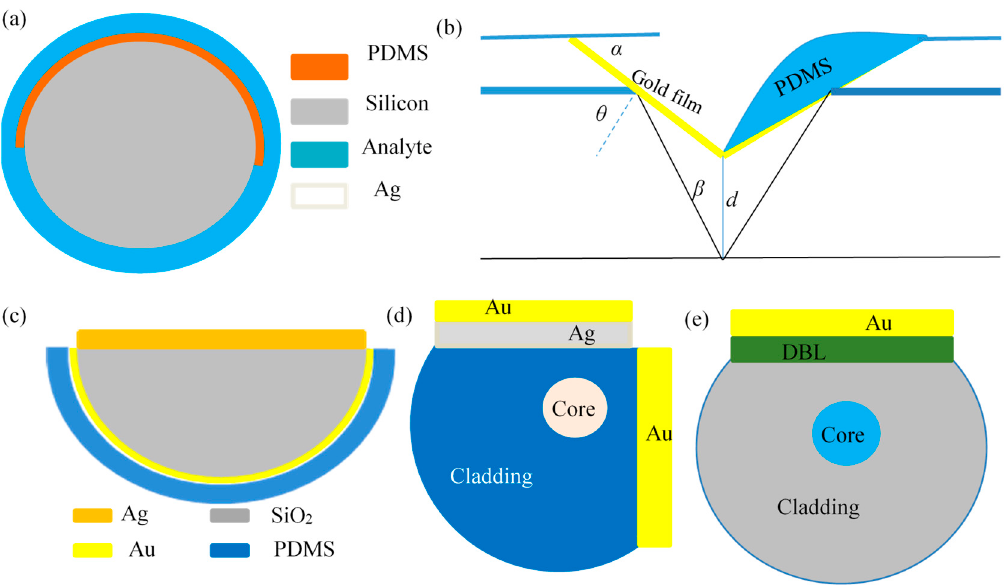
Figure 3. Quartz fiber SPR structure. ( a ) Cylindrical [36]; ( b ) V-shaped [38]; ( c ) D-shaped [39]; ( d ) Vertical double-D [42]; ( e ) Long-range SPR [44].